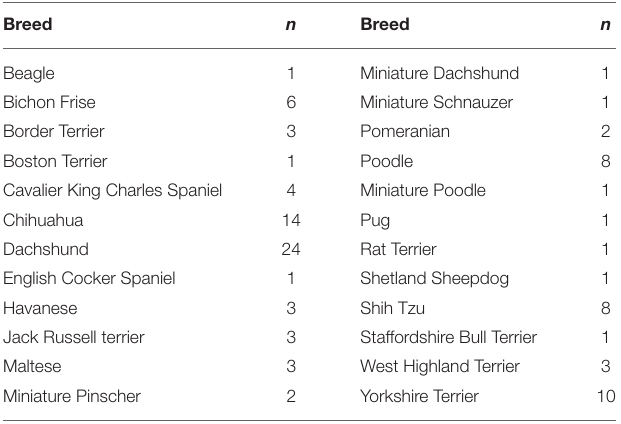
TABLE 1 | Breed distribution. TABLE 2 | M1 tooth root